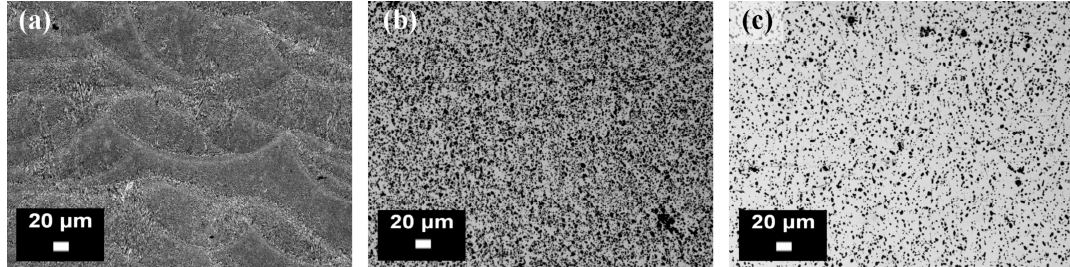
Figure 18. Optical images of an AlSi10Mg alloy produced by means of DMLS and heat treated: ( a ) after a stress relieving at 300 °C for 2 h; ( b ) after a T4 treatment ( c ) after a T6 treatment (from the authors’ own unpublished work).